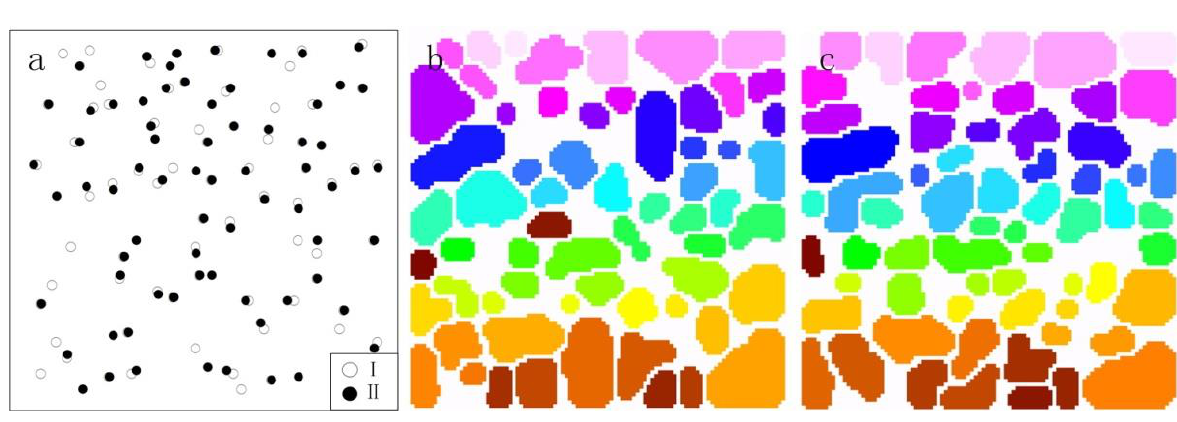
Figure 8. Individual tree location and crown comparison: CHM I vs. CHM II. ( a ) Individual tree locations extracted from CHM I and CHM II; ( b ) crowns extracted from individual trees based on CHM I; ( c ) crowns extracted from individual trees based on CHM